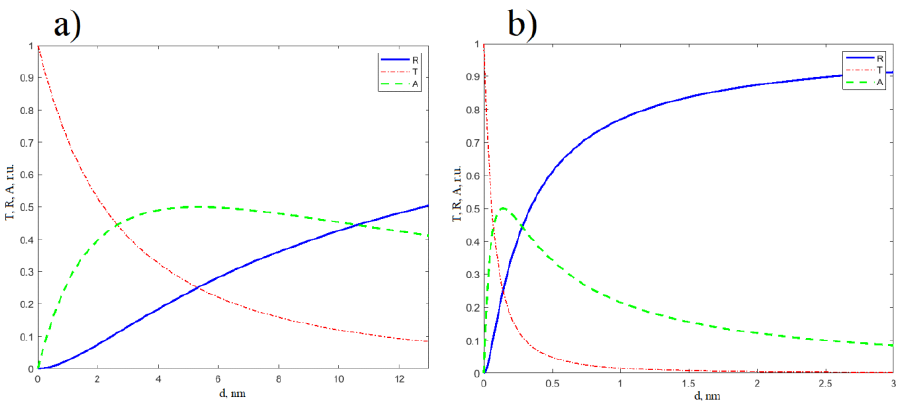
Fig. 5. Simulation results of optical coefficients dependence on the film